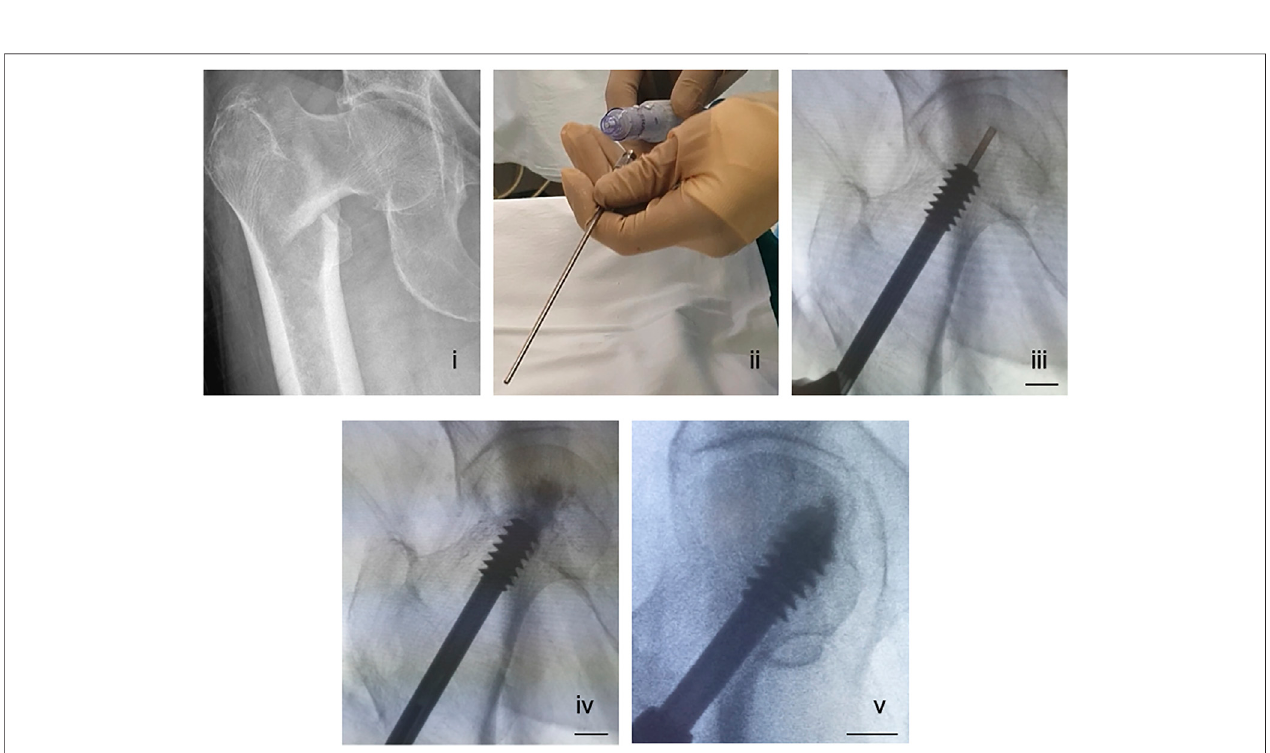
FIGURE 3| A surgical method of delivering aCaS/HA biomaterial through a cannulated lag-screw in a patient undergoing treatment for pertrochanteric fracture. (i) X-ray showing a pertrochanteric fracture. (ii) A photograph of the injection cannula being connected to a regular injection syringe containing the CaS/HA biomaterial. (iii) Placement of the titanium cannula at the most distal end of the pre-drilled canal via the cannulated lag-screw visualized radiographically. (iv) Radiographic image of the CaS/HAbiomaterialbeinginjectedintothepre-drilledcanalin-frontofthelag-screw.(v)Radiographofthe fi nalpositionofthelag-screwwiththebiomaterialaround. Scale bar in panels iii-v is ~1.3